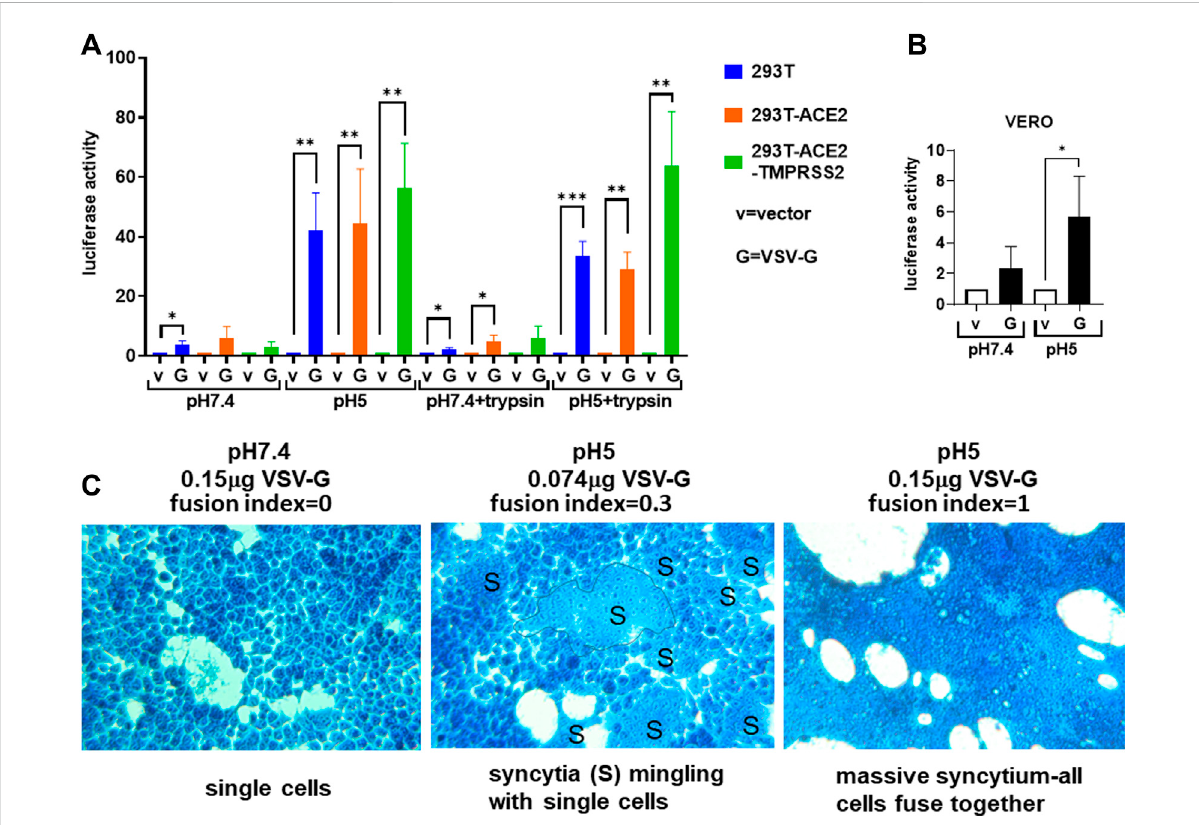
FIGURE 2 Vesicular stomatitis virus glycoprotein triggers universal acidic pH fusion. (A,B) Donor 293T cells were transfected with empty vector (negative control) or the vesicular stomatitis glycoprotein (VSV-G) together with a plasmid encoding the T7 polymerase. 19.000 donor cells were co-cultured with 19,000 target cells (A) (293T, 293T-ACE2, 293T-ACE2-TMPRSS2) or (B) Vero cells transfected with the luciferase and β -galactosidase reporter genes.Theco-culturesweretreatedasindicated.Fusionactivitywasmeasuredasluciferaseactivitynormalizedagainst β -galactosidase activity and expressed as a ratio to their respective vector control in the respective cell type and fusion condition. Data are presented as mean +/ − SD of 3 repeats. * p < 0.05, ** p < 0.01, and *** p < 0.001. (C) Donor 293T cells transfected with 0.15 μ g of VSV-G (left and right) or 0.074 μ g of VSV-G (middle) were co-cultured with target 293T cells and fusion triggered by incubating with pH7.4 (left) or pH5 (middle and right) fusion buffers. Cells were fi xed and stained with methylene blue. A syncytium was outlined. Fusion index was calculated as (S – N)/T where S = number of nuclei in syncytia; N = number of syncytia; T = total number of nuclei. All photomicrographs are of the same magni fi cation and